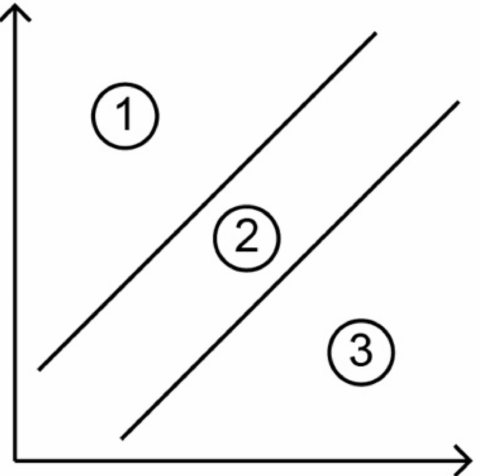
Figure 1. A standard straight line graph, lines with positive slope upwards.